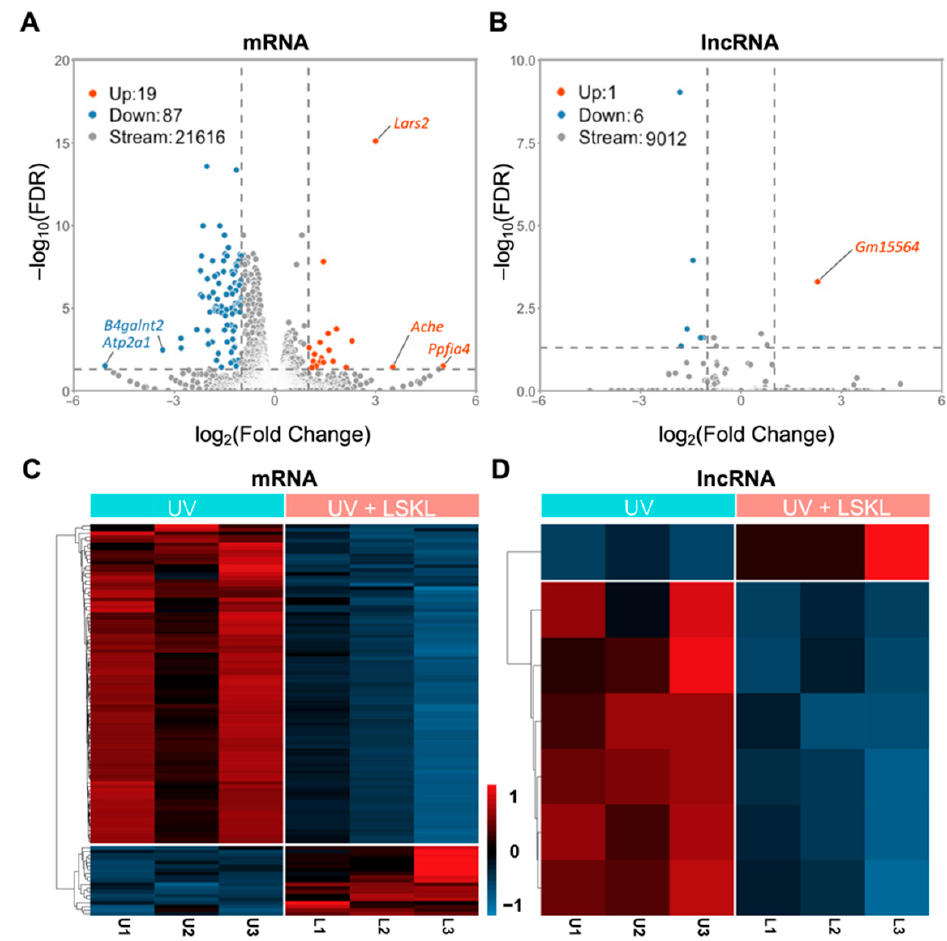
Figure 2. Identification of Tgf- β -associated DE-mRNAs and DE-lncRNAs in 661W cells. ( A , B ) Vol- cano plot illustrating the differential RNA expression level between UV/Ctrl and UV/LSKL 661W cells. The negative Log10 FDR adjusted P values (y-axis) are plotted against the log2 fold changes in expression (x-axis). ( C , D ) Heatmap illustrating the relative RNA expression of UV/Ctrl and UV/LSKL 661W cells. Microarray, n = 3 per group. DE-mRNAs: differentially expressed mRNAs; DE-lncRNAs: differentially expressed lncRNAs. Table 1. The differentially expressed mRNAs and lncRNAs between two UV irradiated 661W cells with or without LSKL preprocessing.